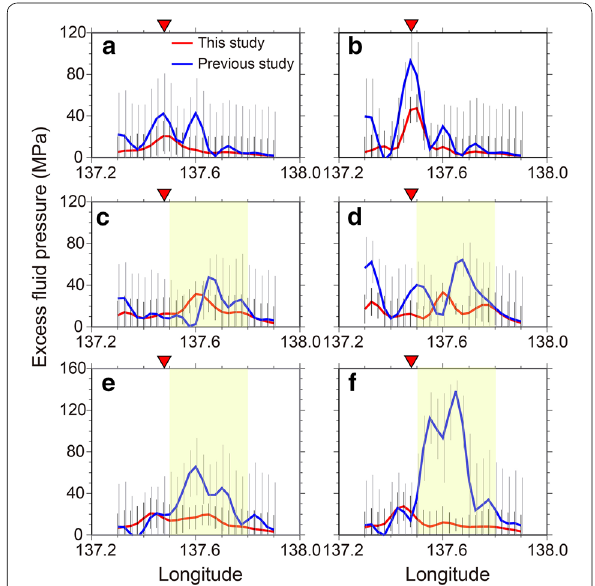
Fig. 3 Comparison of the latitudinal profiles of pore-fluid pressure fields. The profiles at a 36.05° and a depth of 5 km, b 36.05° and a depth of 7.5 km, c 35.95° and a depth of 5 km, d 35.95° and a depth of 7.5 km, e 35.85° and a depth of 5 km, and f 35.85° and a depth of 7.5 km. The red and blue lines denote the profiles in the present study and those in the study by Terakawa et al. (2013b), respectively. The black and light gray vertical lines represent the estimation errors (the 67% confidence region) of pore-fluid pressures in the present study and those in the study by Terakawa et al. (2013b), respectively. The yellow shaded zones in ( c – f ) correspond to the region A. The red inverse triangles denote the longitudinal location of the summit of Mt. Ontake